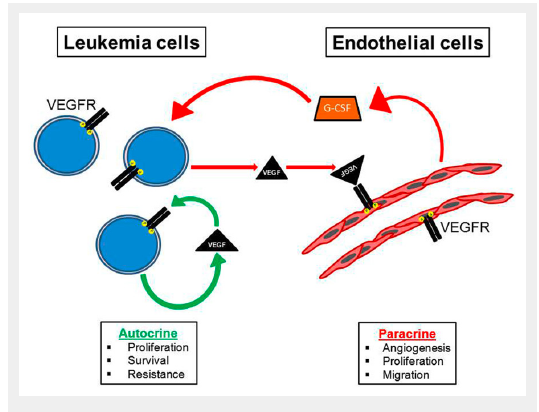
Cross-talk between leukaemic and endothelial cells. Autocrine and paracrine signalling via VEGF promotes the pathogenesis of leukaemia. Paracrine VEGF signalling influences angiogenesis and the bone marrow microenvironment. G-CSF = granulocyte-colony stimulating factor; VEGF = vascular endothelial growth factor; VEGFR = vascular endothelial growth factor